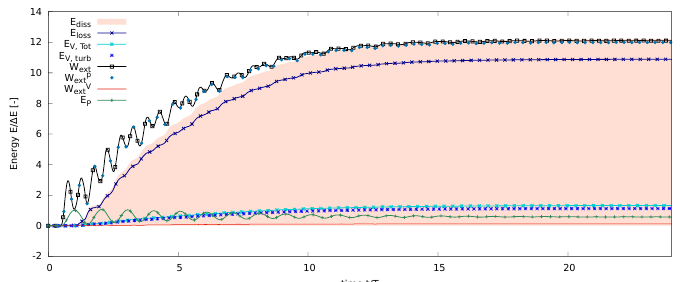
Figure 31. Energy distribution for water 3D simulation at N 50